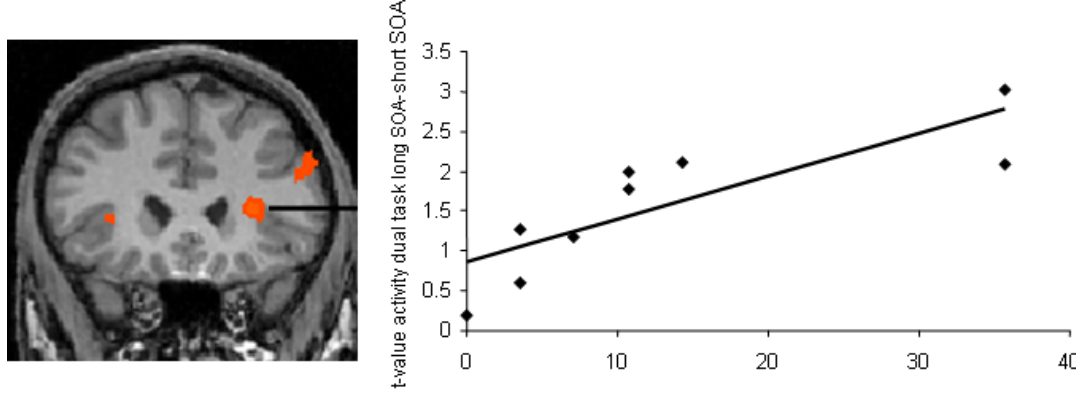
Figure 5. Significant correlation between suppression of VLPFC activity at short SOA and the strength of interference between visual and auditory processing in individual subjects. Strength of interference was calculated as the difference between the percentage of correctly identified letter targets at short and long SOA. ( Figure 2 ) might reflect stimulus-response mapping in the individual task [32–34], which, however, did not interfere in our unspeeded experiment. A third assumption was that one function of workspace neurons may be to support related processing in more local systems [8–10]. The result should be a distributed reduction of stimulus- or task-related activity when attention is focused elsewhere. Our findings in visual modality-specific cortex support this assumption, probably reflecting down-regulating frontal control via middle temporal regions.